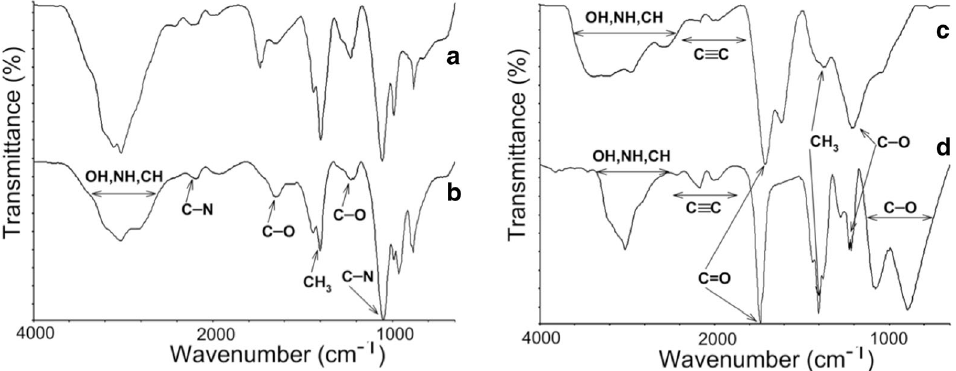
Fig. 6 FT-IR spectra of HS and FS produced by bacterial degradation of coal discard. Minimal salt medium containing coal discard was inoculated with either ECCN 13b or a consortium of Citrobacter strain ECCN 19b, Exiguobacterium strain ECCN 21b, and Serratia strain ECCN 24b (ECCN 14b) and incubated at 37 (cid:3) C for 21 d. Humic and fulvic acid-like substances were extracted, dried, and analysed by FT-IR. Commercial HA ( a ); HS produced from coal discard treated with bacteria ( b ); fulvic acids extracted from commercial humic acid ( c ); and, FS extracted from the HS produced from coal discard treated with bacteria (